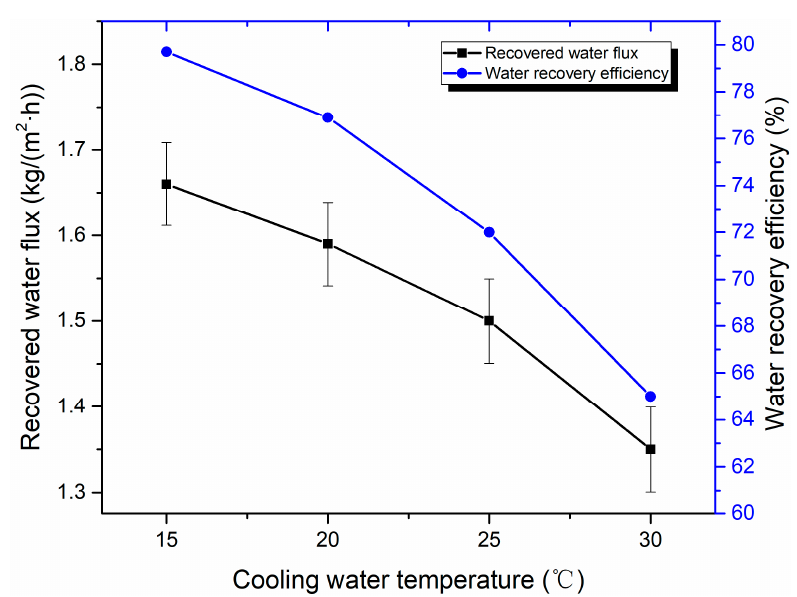
Figure 15. Effect of cooling water temperature on water recovery performance (Experiment Figure 15. E ff ect of cooling water temperature on water recovery performance (Experiment conditions: conditions: flue gas flow rate of 9 L/min, flue gas temperature of 50 °C, and cooling water flow of 1 flue gas flow rate of 9 L / min, flue gas temperature of 50 ◦ C, and cooling water flow of 1 L / L/min).